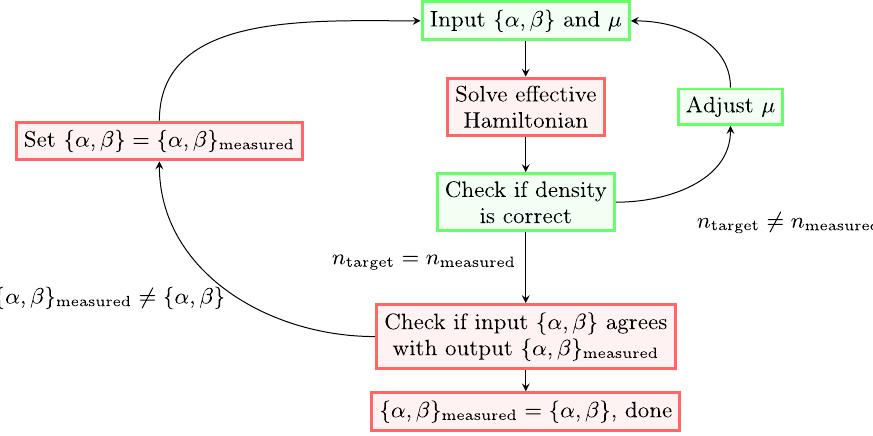
FIG. 3. Schematic representation of the MPS þ MF framework. Green boxes highlight the density-fixation part of the routine. Red boxes denote the mean-field amplitude fixation part. The mean-field amplitude set is denoted by f α ; β g where f α g represent pairing amplitudes and f β g the exchange